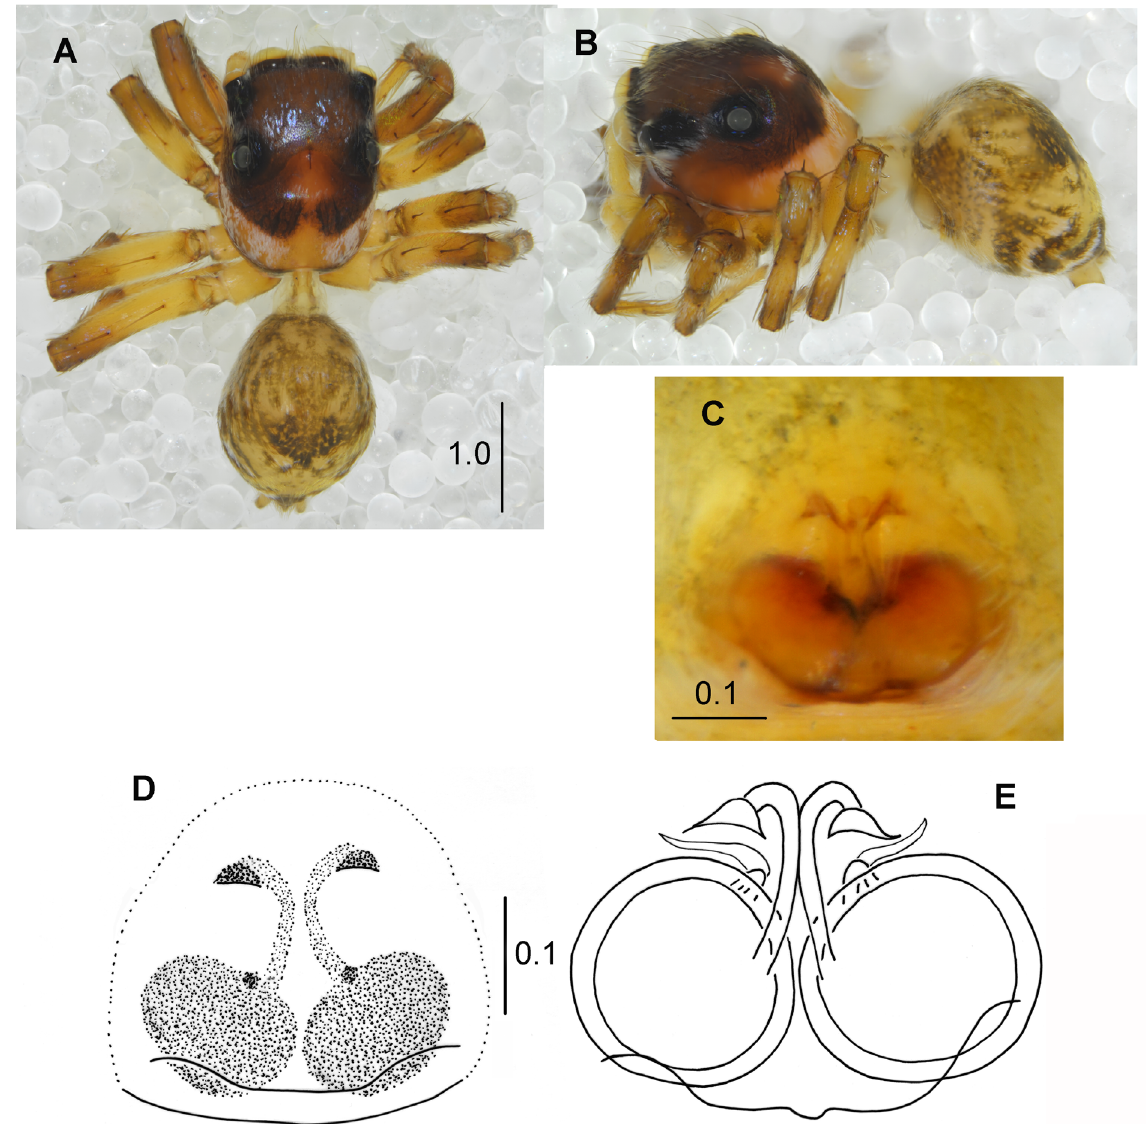
Fig. 44. Phintella globosa sp. nov., ♀, holotype (MNHN). A . Habitus, dorsal view. B . Habitus, lateral view. C–D . Epigyne. E . Internal structure of e pigyne . As in Fig. 44C–D. Copulatory openings hidden under sclerotized ‘shields’, seminal ducts weakly sclerotized, thin and delicate, spermathecae huge, very strongly sclerotized (Fig. 44E). Distribution Only known from the type locality, Cavally Forest, Ivory Coast.